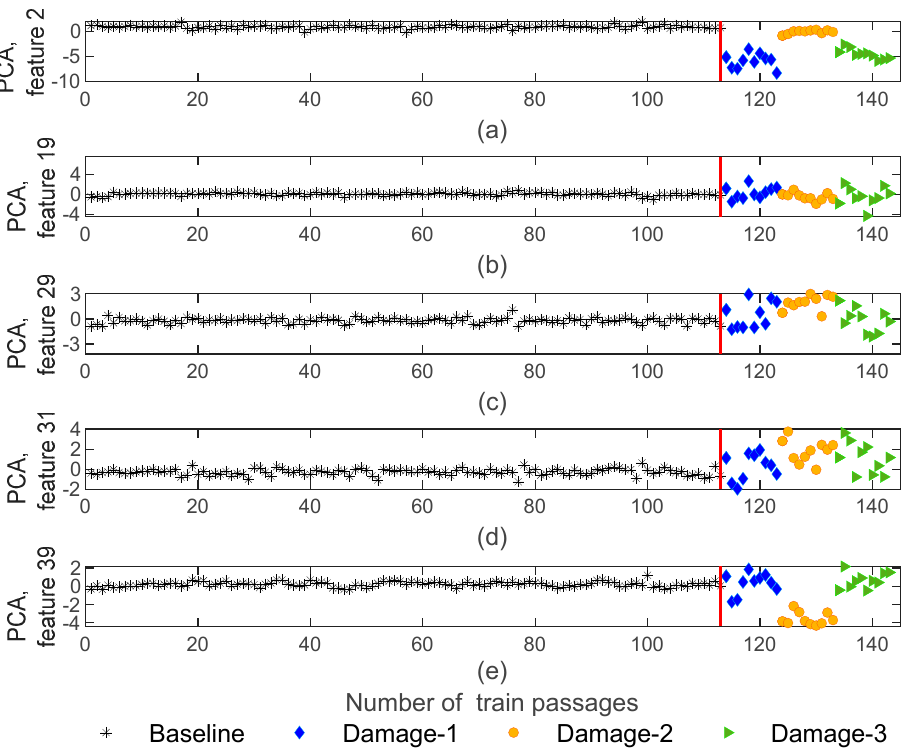
Figure 12. AR—feature normalization for all 143 baseline and damage scenarios for accelerometer 3: ( a ) PCA for feature 2, ( b ) PCA for feature 19, ( c ) PCA for feature 29, ( d ) PCA for feature 31, ( e ) PCA for feature 39.